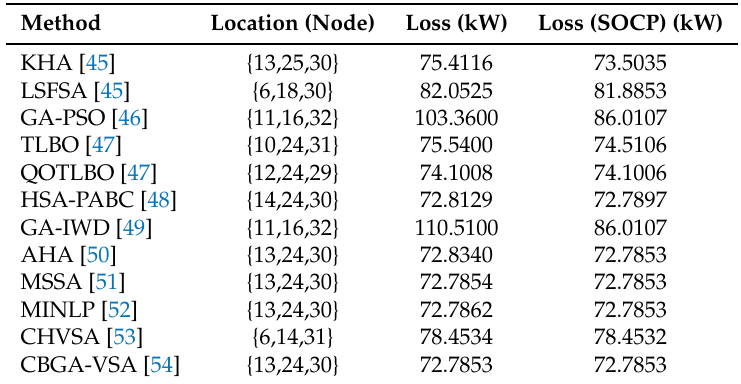
Table 8. Comparative results between literature approaches and the second-order cone programming (SOCP) for optimal power